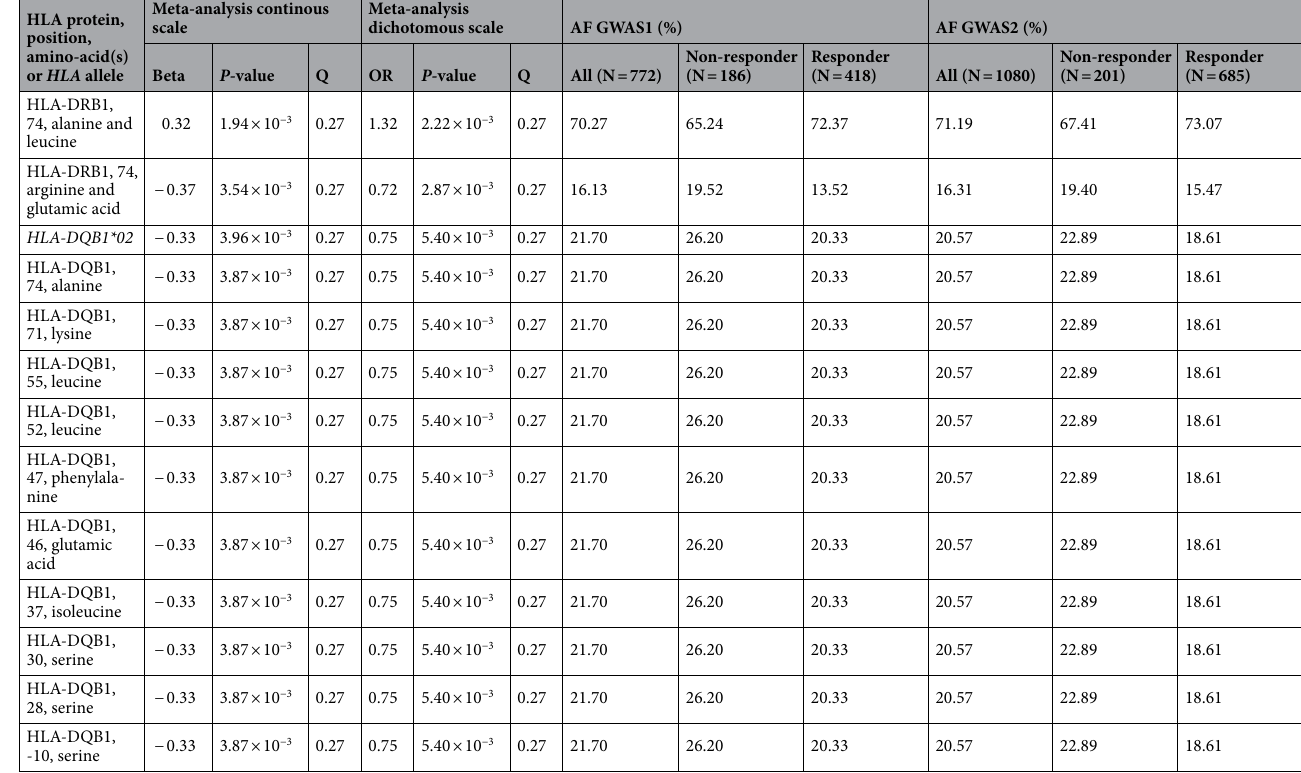
Table 3. Results of the meta-analysis for continuous and dichotomous response outcome in additive model. AF: allele frequency; Q-value: the q -value gives the expected positive false discovery rate; Non-resp = Li non responders (ALDA subscale A less than or equal to 3); Resp = Li responders (ALDA subscale A greater than or equal to 7).